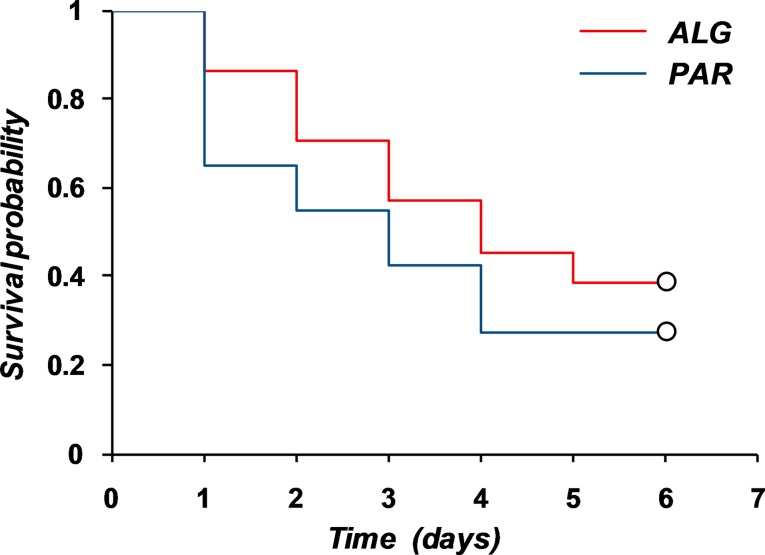
Kaplan–Meier estimations of the pain survival curves.